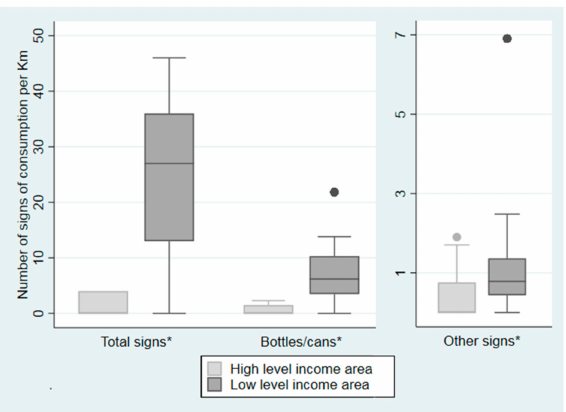
Figure 7. Distribution of the signs of alcohol consumption according to the income level of the district in the city of Madrid, Spain, in 2018. It was measured as: (1) Total signs of alcohol consumption (bottles and / or cans, people drinking alcohol or disposable cups) identified along one kilometer of roadway within the census tract; (2) Bottles and / or cans identified in along one kilometer of roadway within the census tract; (3) Other signs of alcohol consumption di ff erent from bottles or cans such as people drinking alcohol or disposable cups identified along one kilometer of roadway within the census tract. * Significant di ff erences. p -value were estimated with a Wilcoxon test between a high-income level area (leisure area) and a low-income level area (residential area) with a level of confidence of